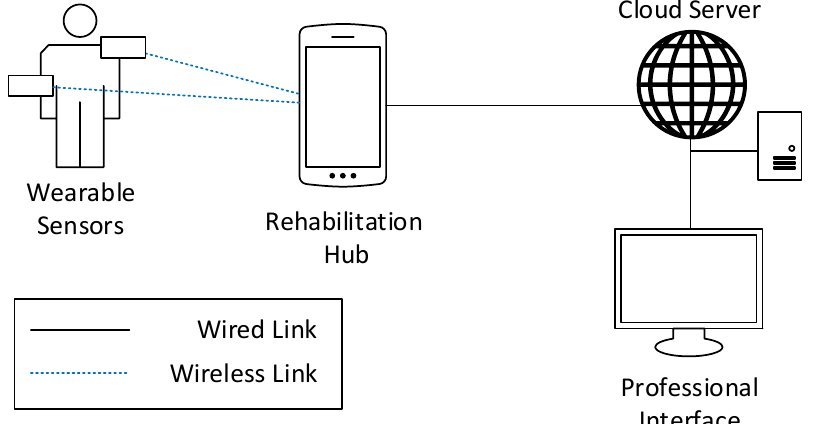
Figure 4. Example of deployment for the single-user physiotherapy use case.